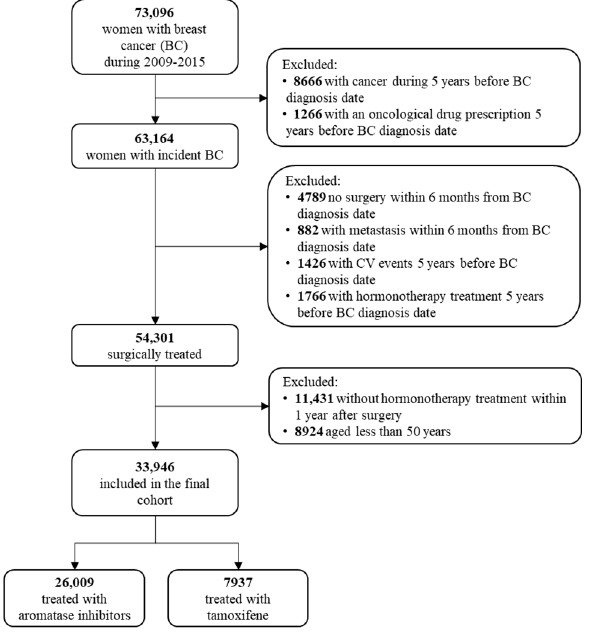
Figure 1. Flow chart of inclusion and exclusion criteria in the final cohort